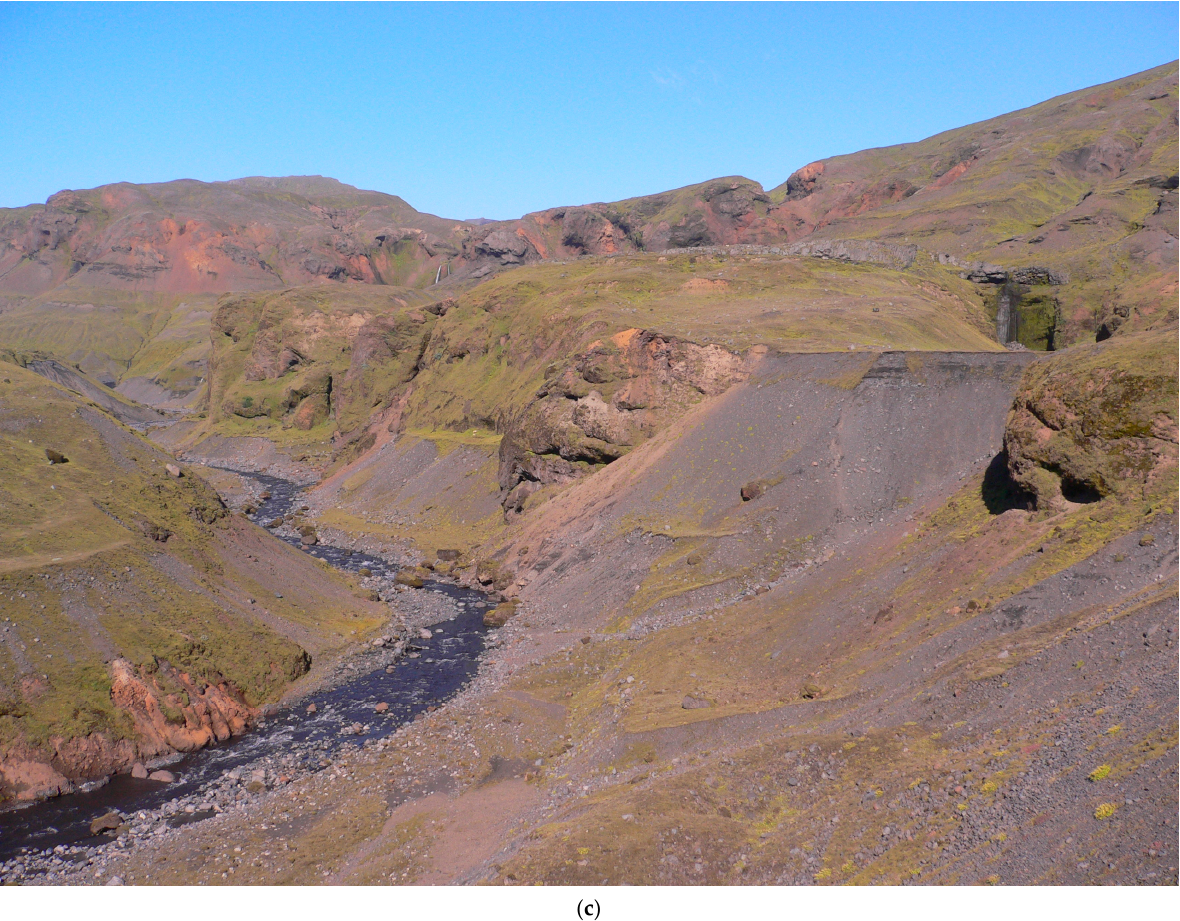
Figure 15. Glacifluvial landforms on the north Sandfellsjökull foreland: ( a ) Ground view of kame terraces, deltas and shorelines on the lower slopes of the fluted bedrock ridge. Visible at the far left is the col between the bedrock ridge and the western mountain slopes; ( b ) Aerial photograph extract (NERC ARSF 2007) of the kame terraces, deltas and shorelines, showing small areas of push moraine development; and, ( c ) Small lake (“inwash”) delta in a steep-sided mountain valley to the north of the foreland.